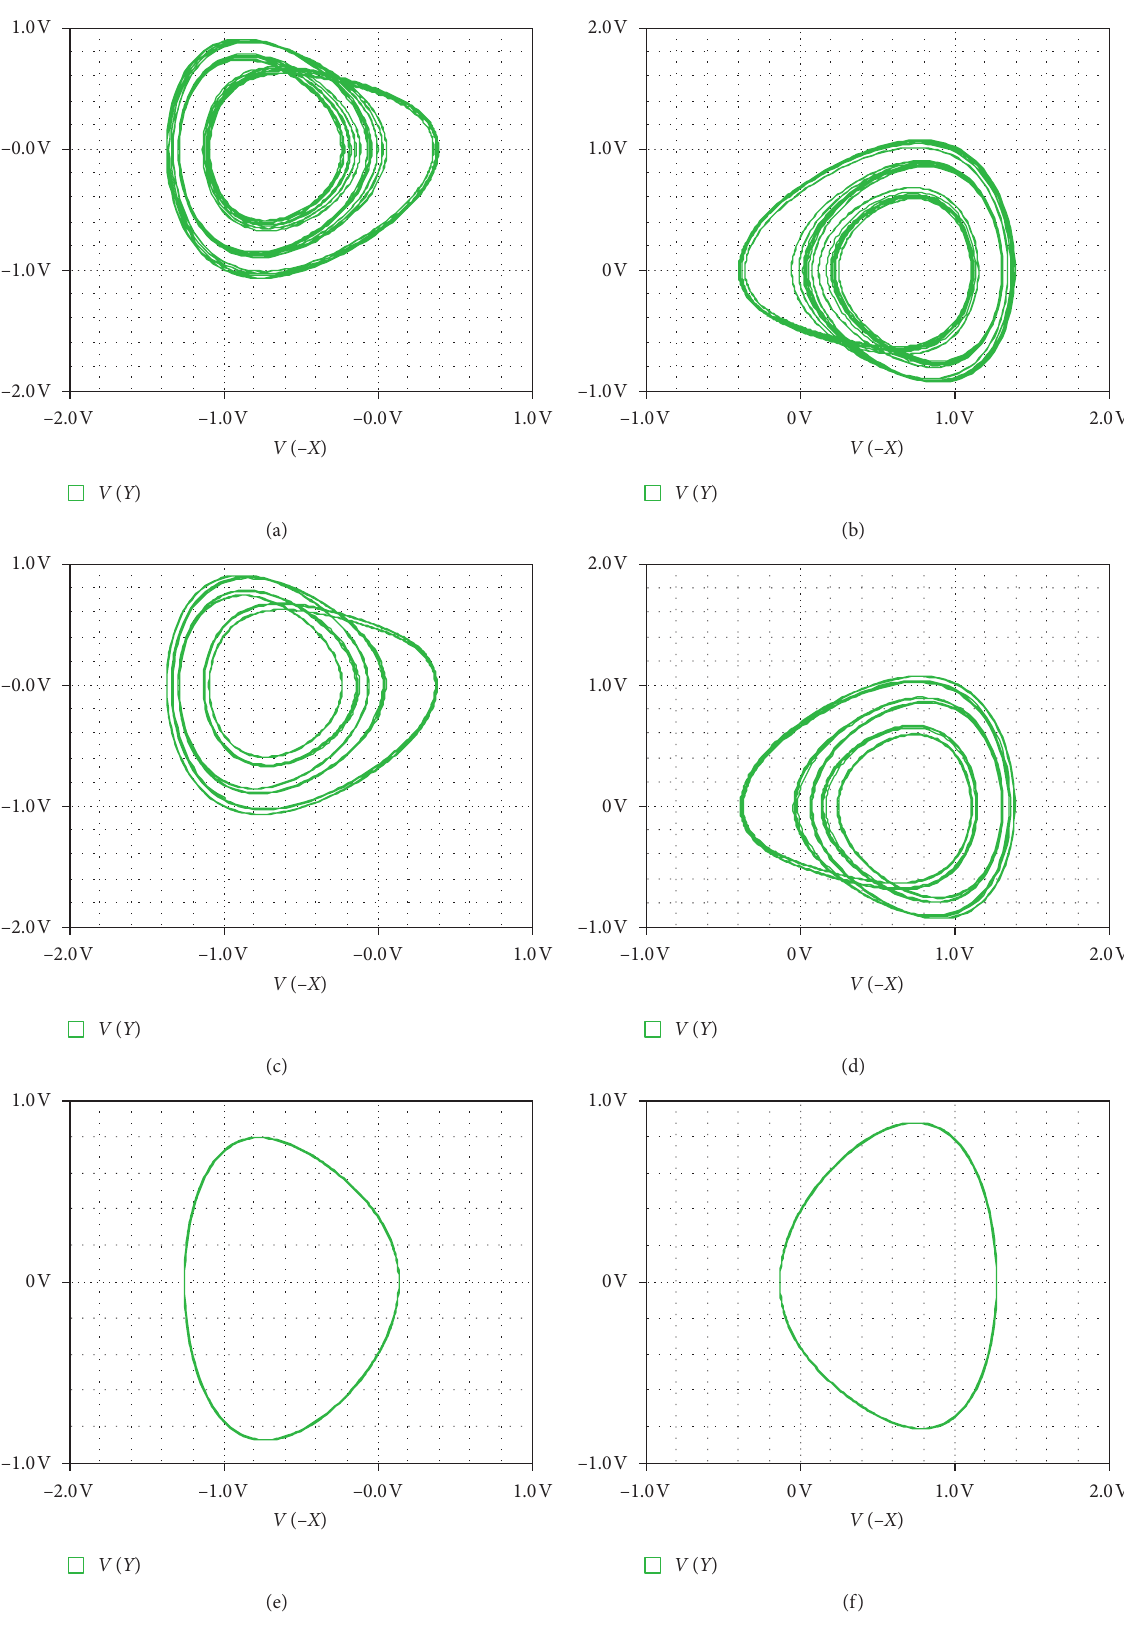
� 1M Ω , R � 3 . 745 k Ω for different values of the m k